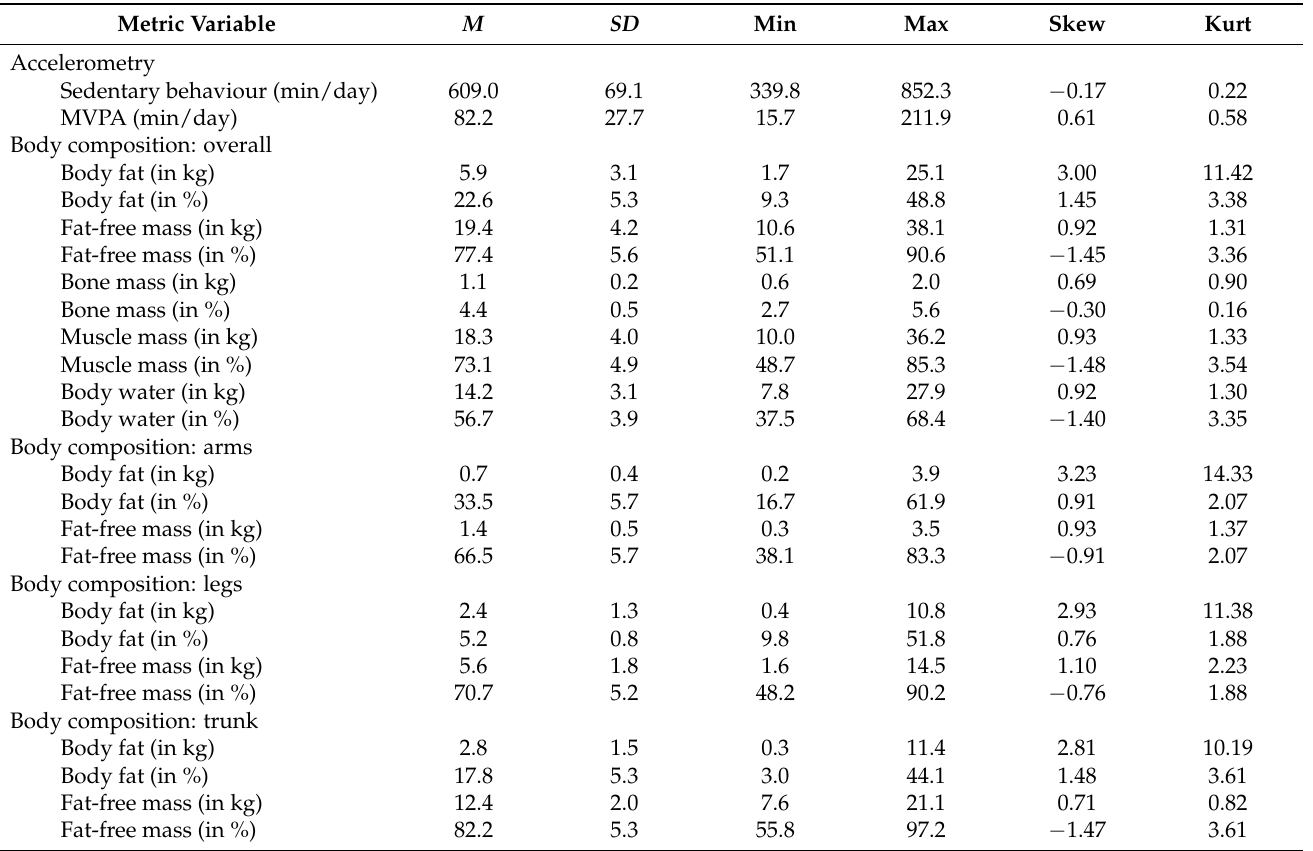
Table 1. Descriptive statistics for the total sample for physical activity, sedentary behaviour, body composition measures, and anthropometric